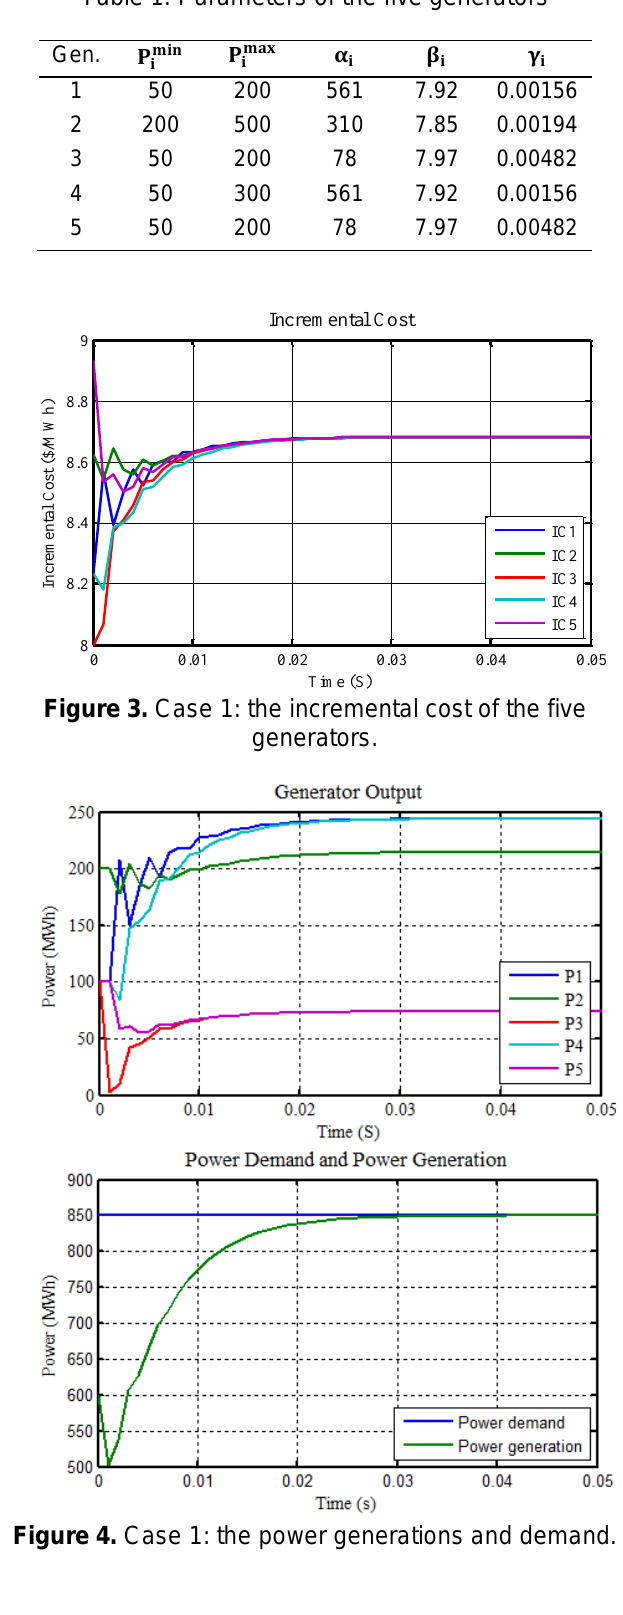
Table 1. Parameters of the five generators